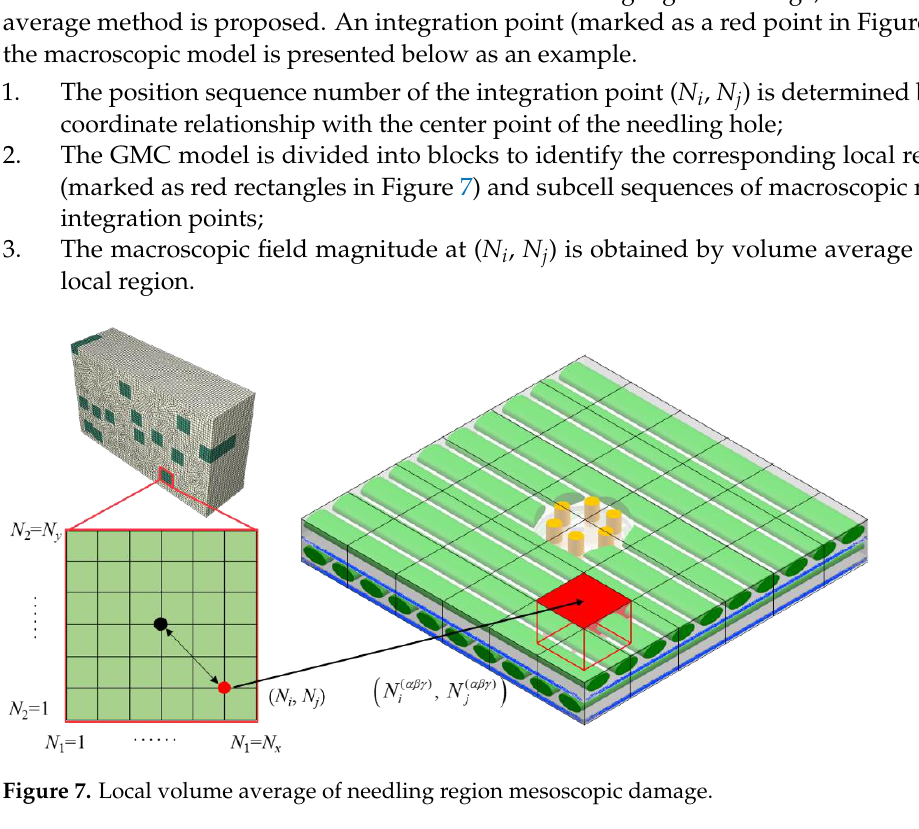
9 of 17 Table 2. Predicted material elastic properties (unit of elastic modulus and shear modulus: GPa). E x